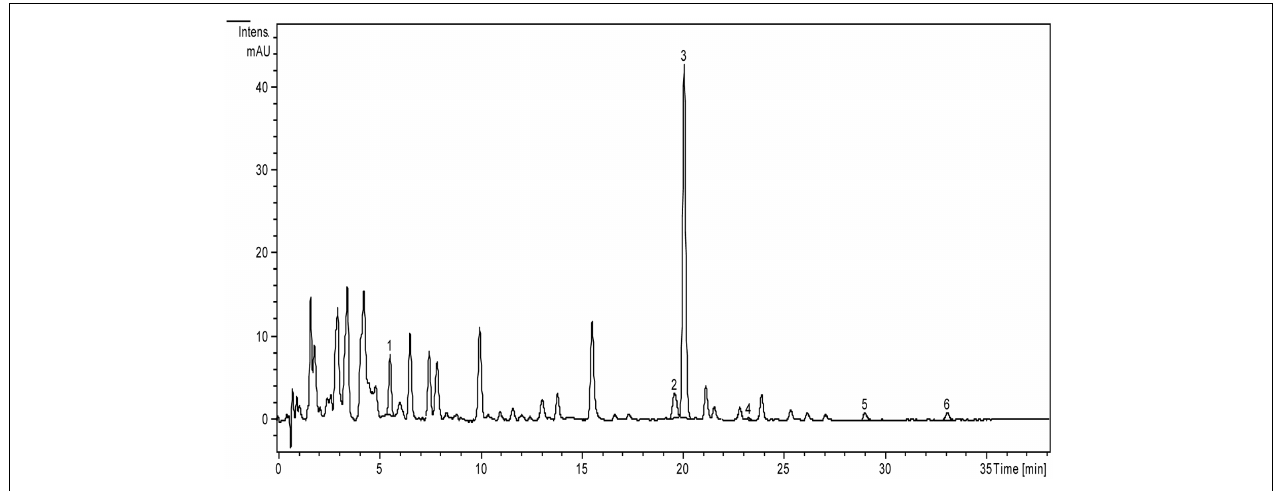
FIGURE 1 | HPLC chromatogram of polyphenols from A. laxmannii aerial parts extract. The identified compounds: chlorogenic acid (1), isoquercitrin (2), rutin (3), quercitrin (4), luteolin (5), apigenin (6). TABLE 2 | The content of polyphenolic compounds in A. laxmannii extracts by HPLC ( µ g/g dw). Polyphenolic compounds